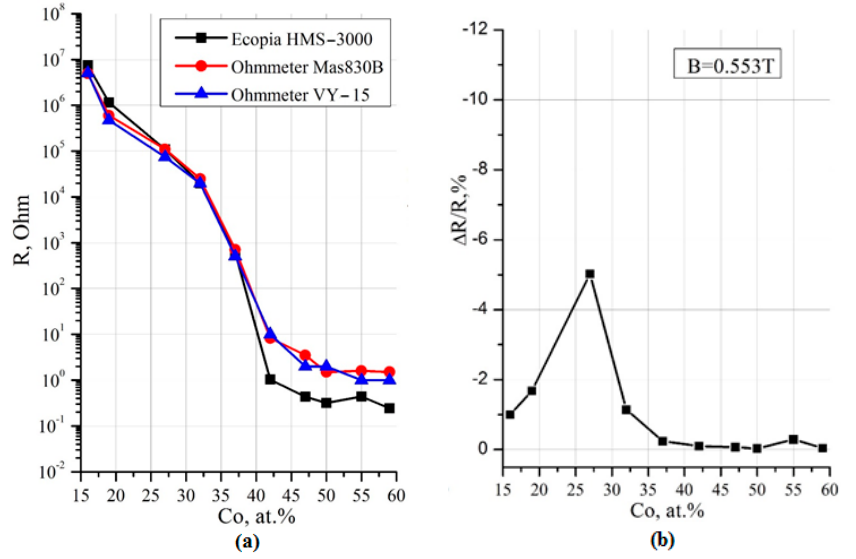
Figure 2. Concentration dependences of electrical resistance ( a ) and magnetoresistance ( b ) of Co x (MgF 2 ) 100-x nanocomposites. Table 2. Concentration dependence of the total electric resistance R and capacitance C of the nanocomposites Co x (MgF 2 ) 100-x